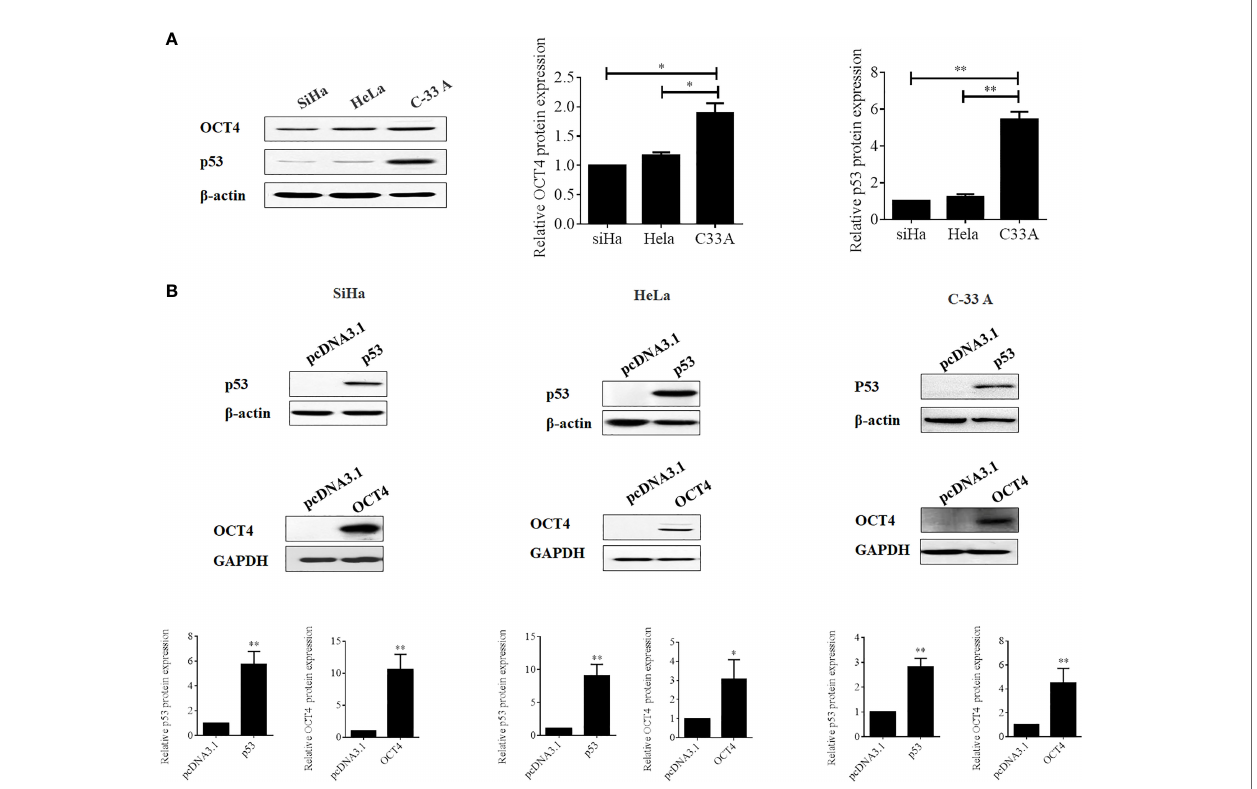
FIGURE 4 | Evaluation of the ef fi cacies of OCT4 and p53 overexpression plasmids in cervical cancer cells. (A) Western blot analysis of the basal protein levels of OCT4 and p53 in SiHa, HeLa, and C-33A cells; b -actin was used as a control. (B) Western blot analysis of the ef fi cacies of OCT4 and p53 overexpression plasmids transfected in SiHa, HeLa, and C-33A cells; GAPDH and b -actin were used as controls. * p < 0.05, ** p < 0.01 vs.